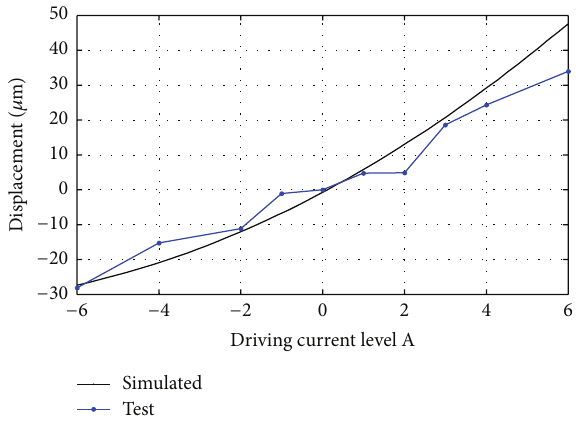
Figure 18: Test displacement curve and its comparison with simu- lated